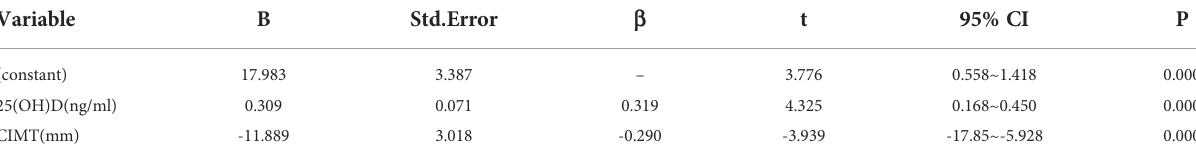
TABLE 3 Correlation analysis between IIEF-5 score,serum 25(OH)D level and CIMT values. Variable B